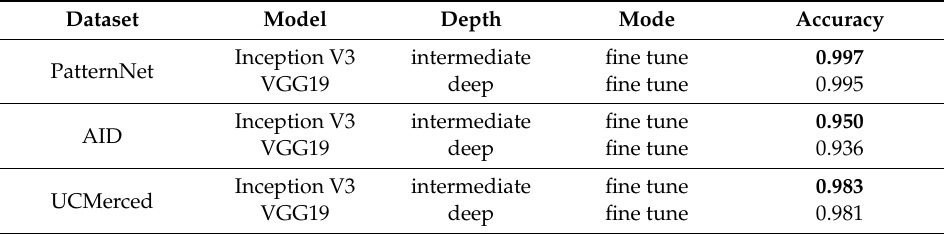
Table 7. Best test set accuracy for Inception V3 and VGG19 version for each dataset using SGD (1e-3) momentum 0.9